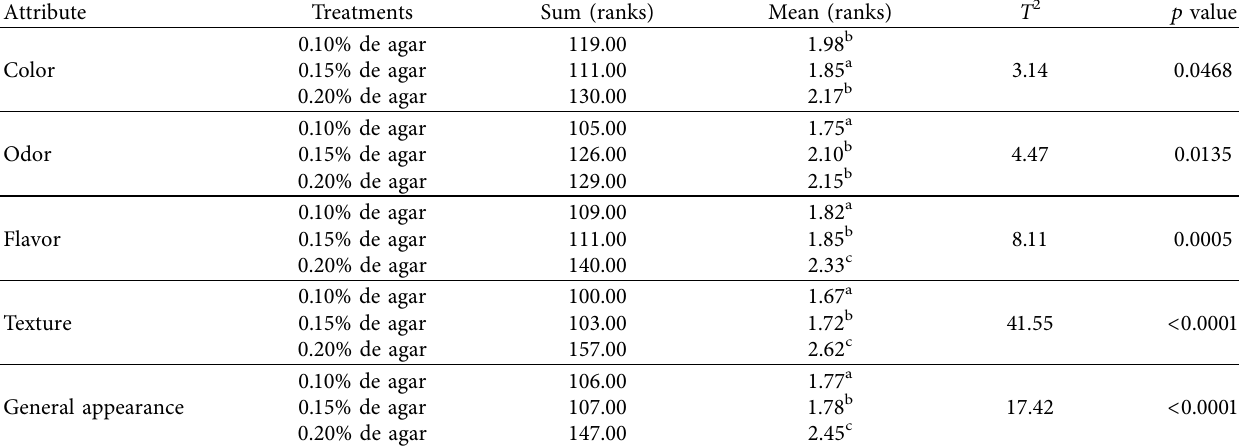
Table 2: Results of the Friedman test between treatments for each sensory attribute.